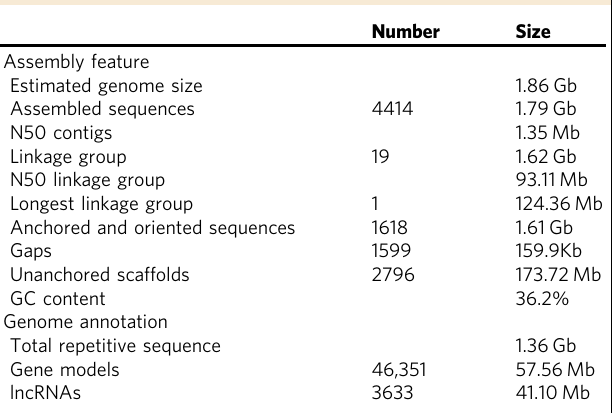
Table 1 Statistics of the Mikaina micrantha genome and gene